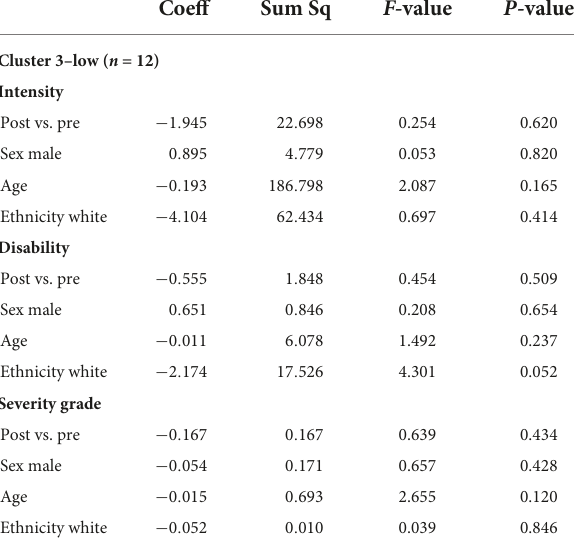
TABLE 6 Multivariable ANOVA, adjusted for demographics (sex male vs. female, age, ethnicity white vs. non-white) for cluster 3-low ( n = 12). Coeff Sum Sq F- value P -value